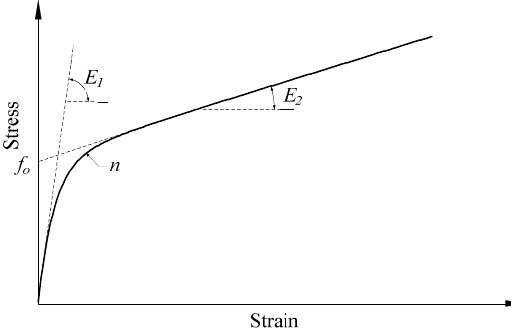
Figure 3. Stress-strain relationship (Equation (7)).